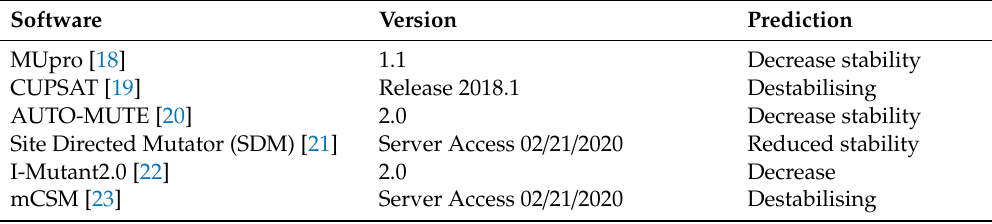
Figure 4. Crystallographic structure of FR α protein, from the Protein Data Band (4LRH). The folate is in green, the folate binding site is colored in orange. The Cys66Tyr substitution position induced by the pathogenic variant described in our case report is represented in red while the disulfide bond between Cys66 and Cys109 is in dark blue. Table 3. Prediction of protein instability from different software programs for the pathogenic variant, Cys66Tyr.